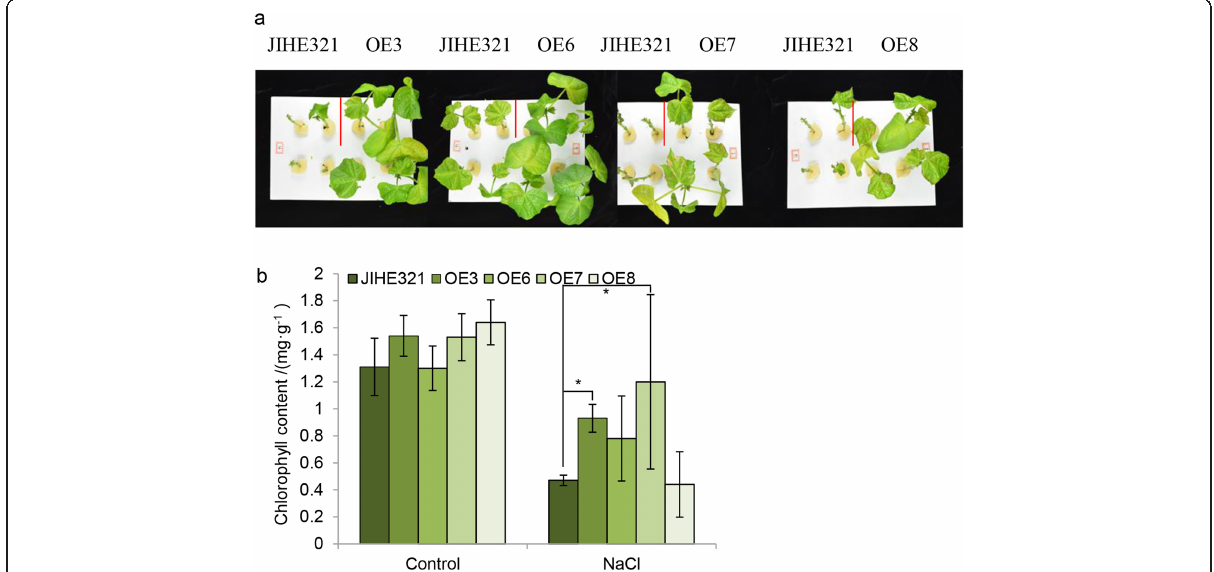
Fig. 2 Ectopic-expression of SAG12::IPT induces salt tolerance in cotton seedlings. a Ectopic expressing SAG12::IPT cotton plants are more tolerant to salt stress compared with JIHE321 control plants. b Ectopic expression of SAG12::IPT induces chlorophyll content in cotton leaves. The data are shown as means ± SD from three independent repeats ( n = 3, * P <